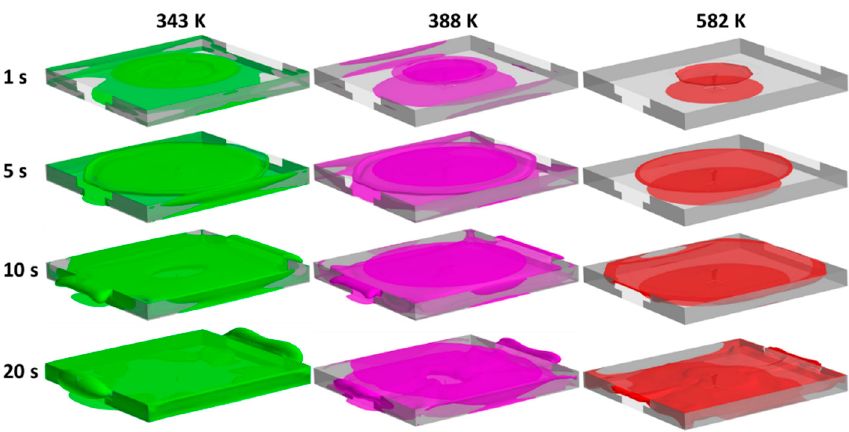
Figure 4. Iso-surfaces showing no-harm ( left ), pain limit ( centre ) and fatality temperature ( right ) for ignited hydrogen release in case 1 (TPRD = 3.34 mm, constant upward release from distance 2.1 m to the ceiling, no car body).